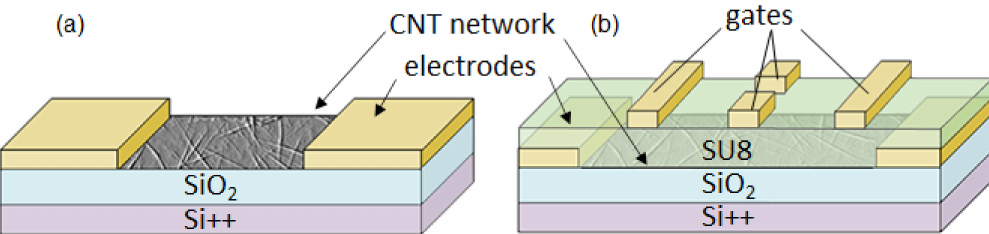
Figure 1. Schematics of the device designs: ( a ) an open channel carbon nanotube (CNT) network multi-electrode device and ( b ) an SU-8 encapsulated multi-top gate CNT network field effect transistor